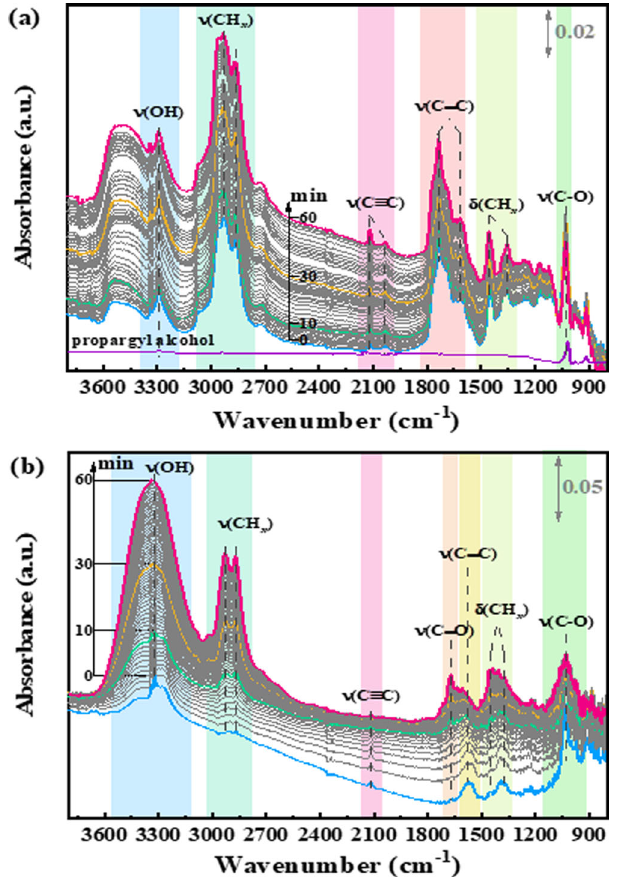
Fig. 4 In situ DRIFT spectra. DRIFT spectra of the reaction of propargyl alcohol over the Pd/ZnO-400 catalyst at 30 °C in a Ar and b 10 vol% H 2